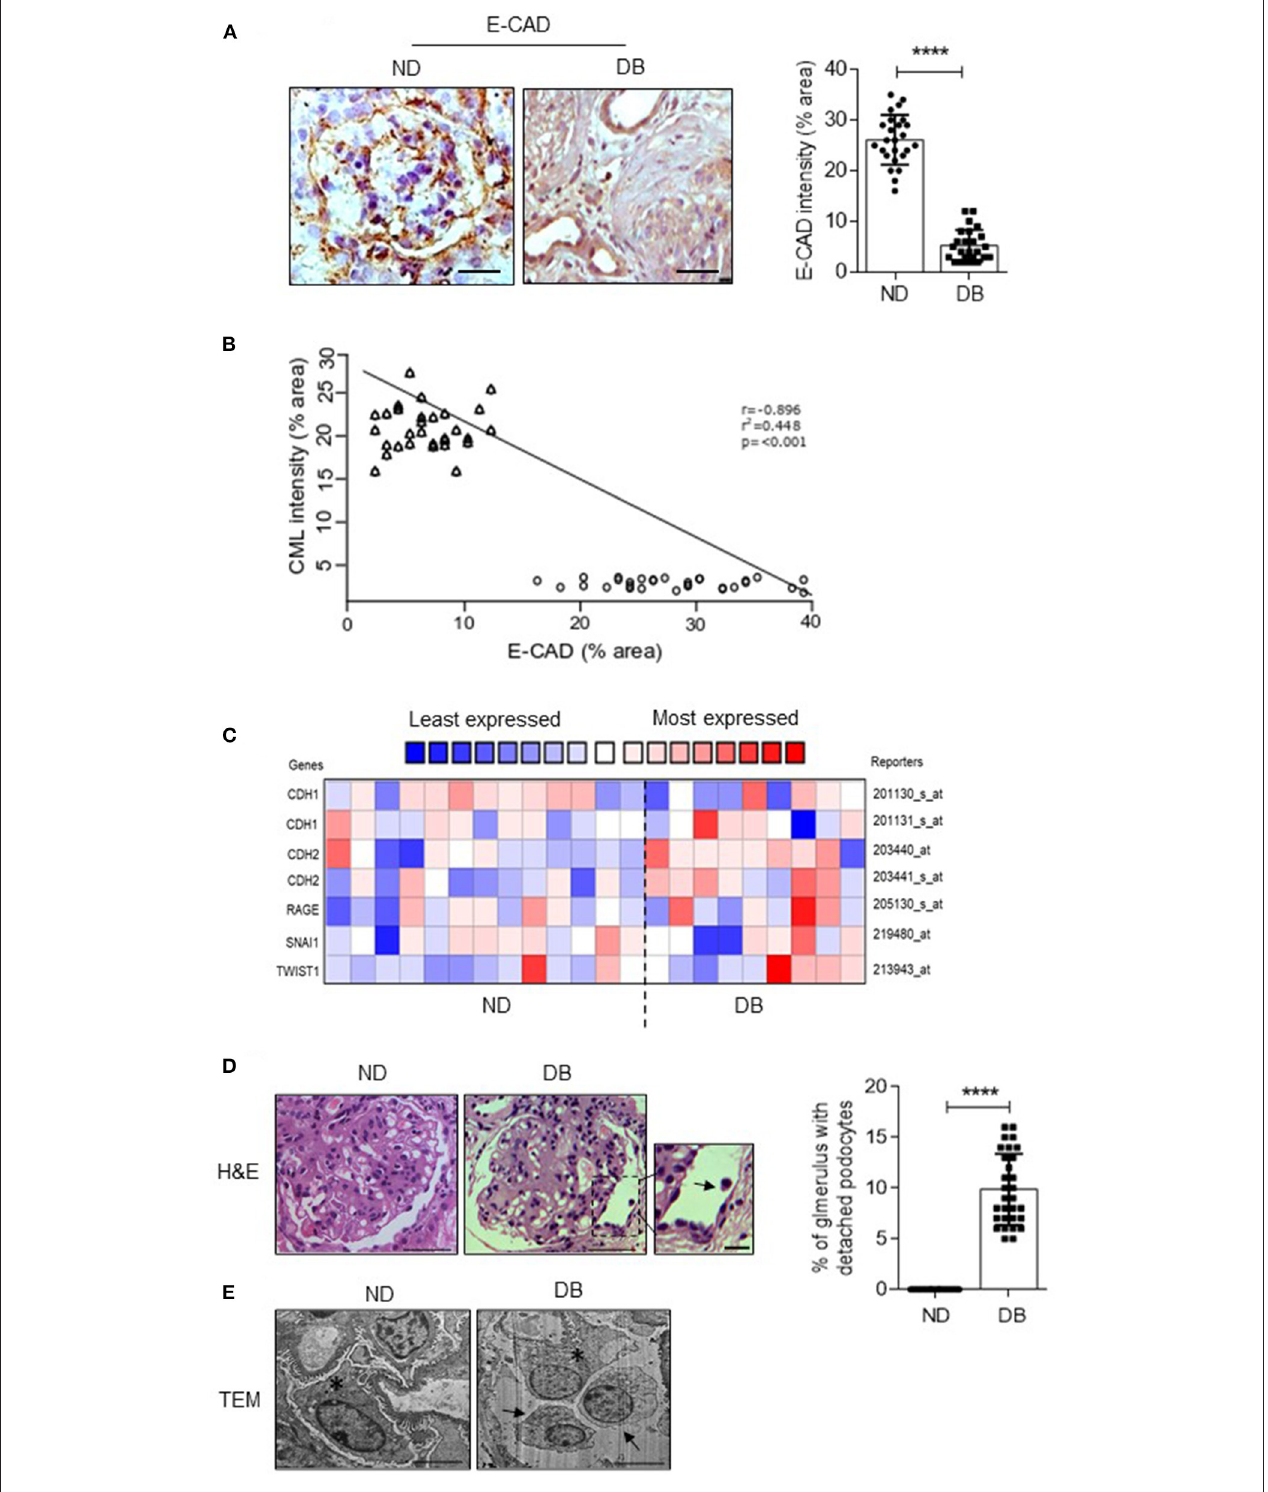
FIGURE 3 | (A) Immunohistochemical analysis of E-cadherin in the kidney biopsies sections from ND and DB groups (Left). Magnification (x 630). Scale bar = 20 µ m. The stained area (%) per field from glomerulus was quantified, and each data point represents the average value of 6 glomeruli from ND and DB both the groups (Right). **** P < 0.0001. The intensity of glomerular expression of E-cadherin was quantified using ImageJ. (B) Correlation between CML vs. E-CAD expression in the glomeruli from ND and DB biopsy samples. Correlation is significant at the 0.001 level (2-tailed). (C) Nephroseq analysis comparing CDH1 (E-cadherin),